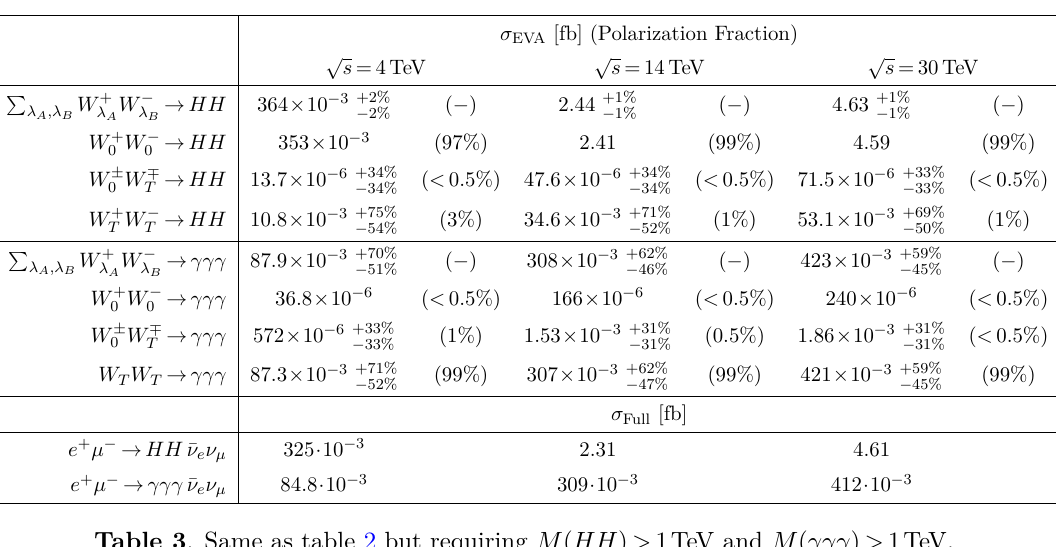
Table 3 . Same as table 2 but requiring M ( HH ) > 1TeV and M ( γγγ ) > 1TeV